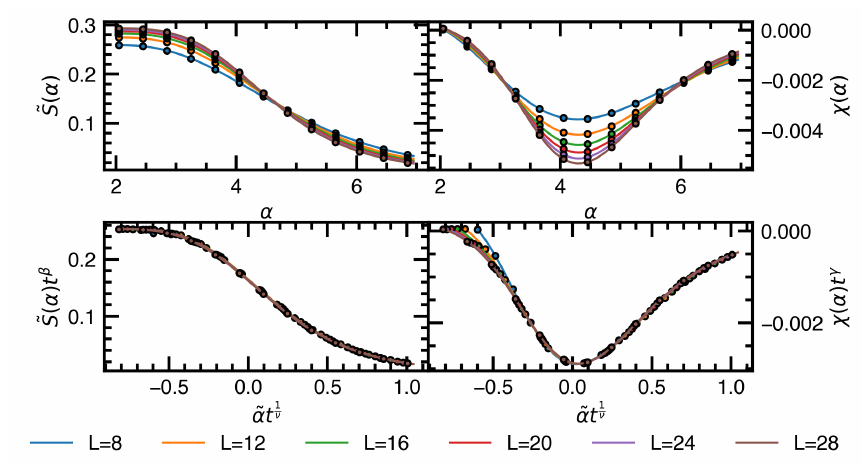
Figure 4: In the top panels we plot ˜ S ( α ) and χ ( α ) nearby the expected transition α . The results of the data collapse for the ansatz Eq. (17) are plotted in in the lower c panels. The best fit gives an estimate of α